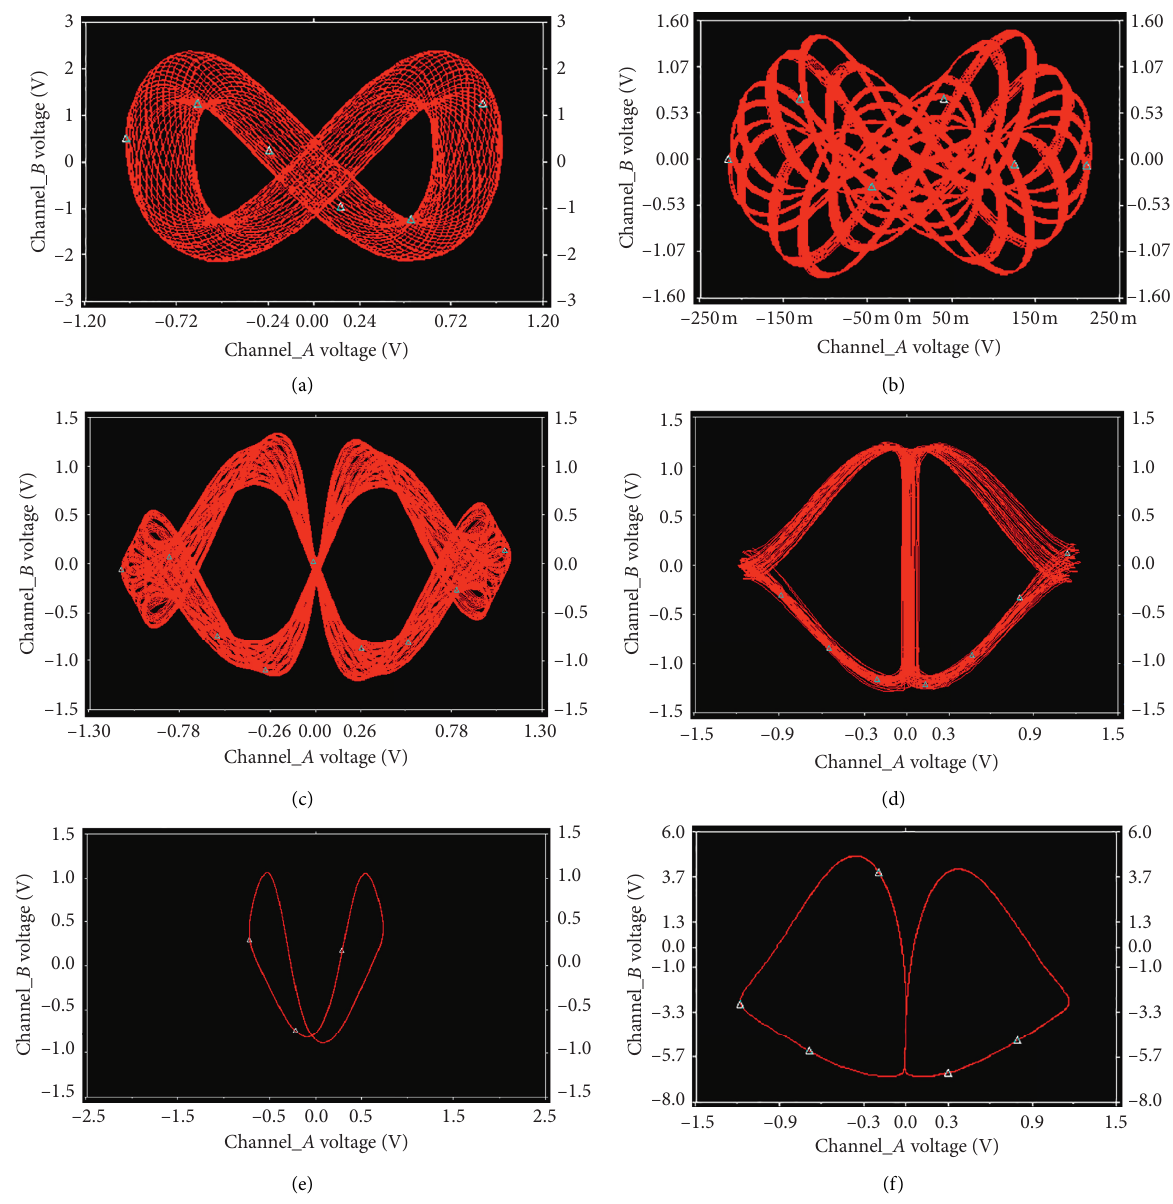
Figure 8: Circuit simulation results of case A. (a) a � − 5, b � 0. (b) a �− 4, b � 0. (c) a �− 0.8, b � 0. (d) a � − 0.2, b � 0. (e) a �− 4.5, b �− 1. (f) a � − 0.8, b �−